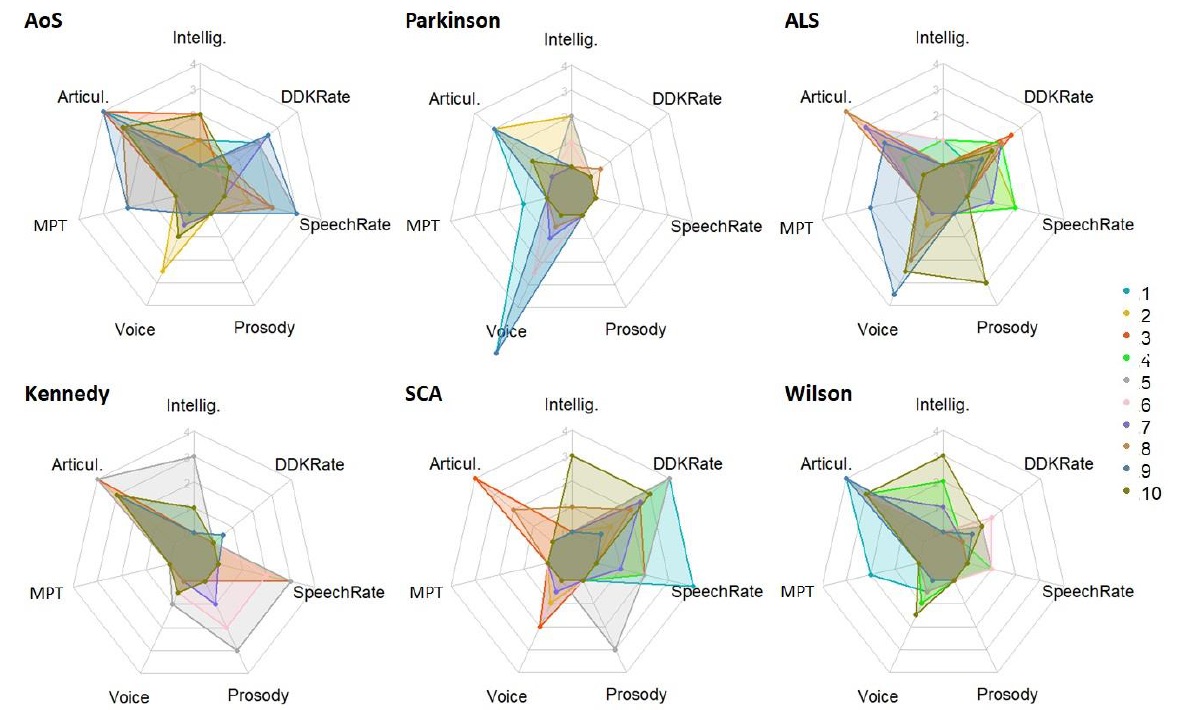
Figure 1. Individual DevS in each assessed speech dimension in each clinical group, from 0 to 4 for intelligibility, articulation, maximum phonation time (MPT), speech rate and prosody. For voice and diadochokinetic (DDK) rate the DevS is a composite computation of six and four DevS, respectively, with a maximum of 6. Articul: articulation; Intellig: Intelligibility; AoS: post-stroke apraxia of speech; ALS: mixed dysarthria in amyotrophic lateral sclerosis; Kennedy: flaccid dysarthria in Kennedy disease; SCA: ataxic dysarthria in spinocerebellar ataxia; Wilson: mixed dysarthria in Wilson disease.